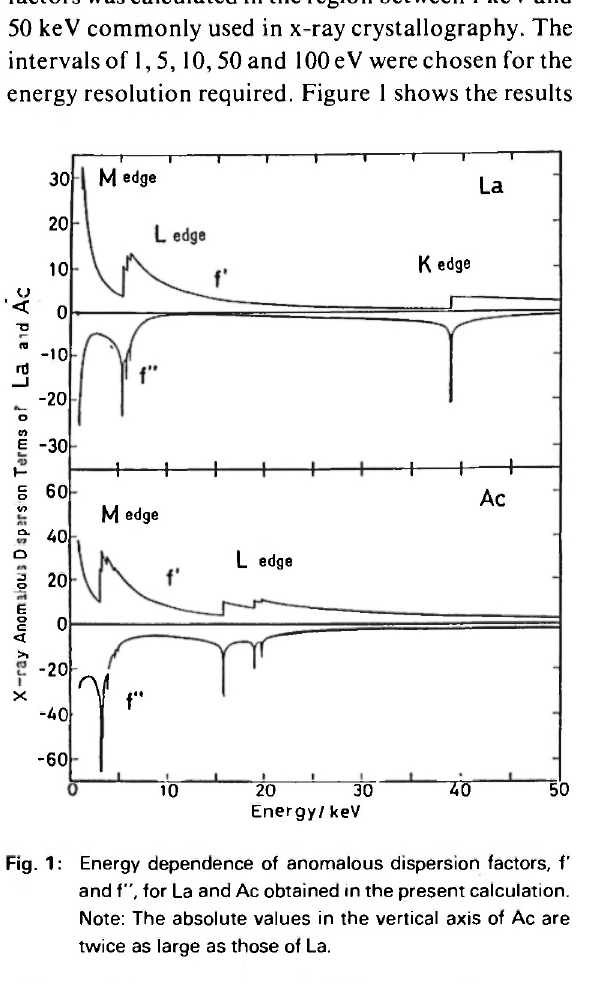
Fig. 1: Energy dependence of anomalous dispersion factors, f and f", for La and Ac obtained in the present calculation. Note: The absolute values in the vertical axis of Ac are twice as large as those of La.